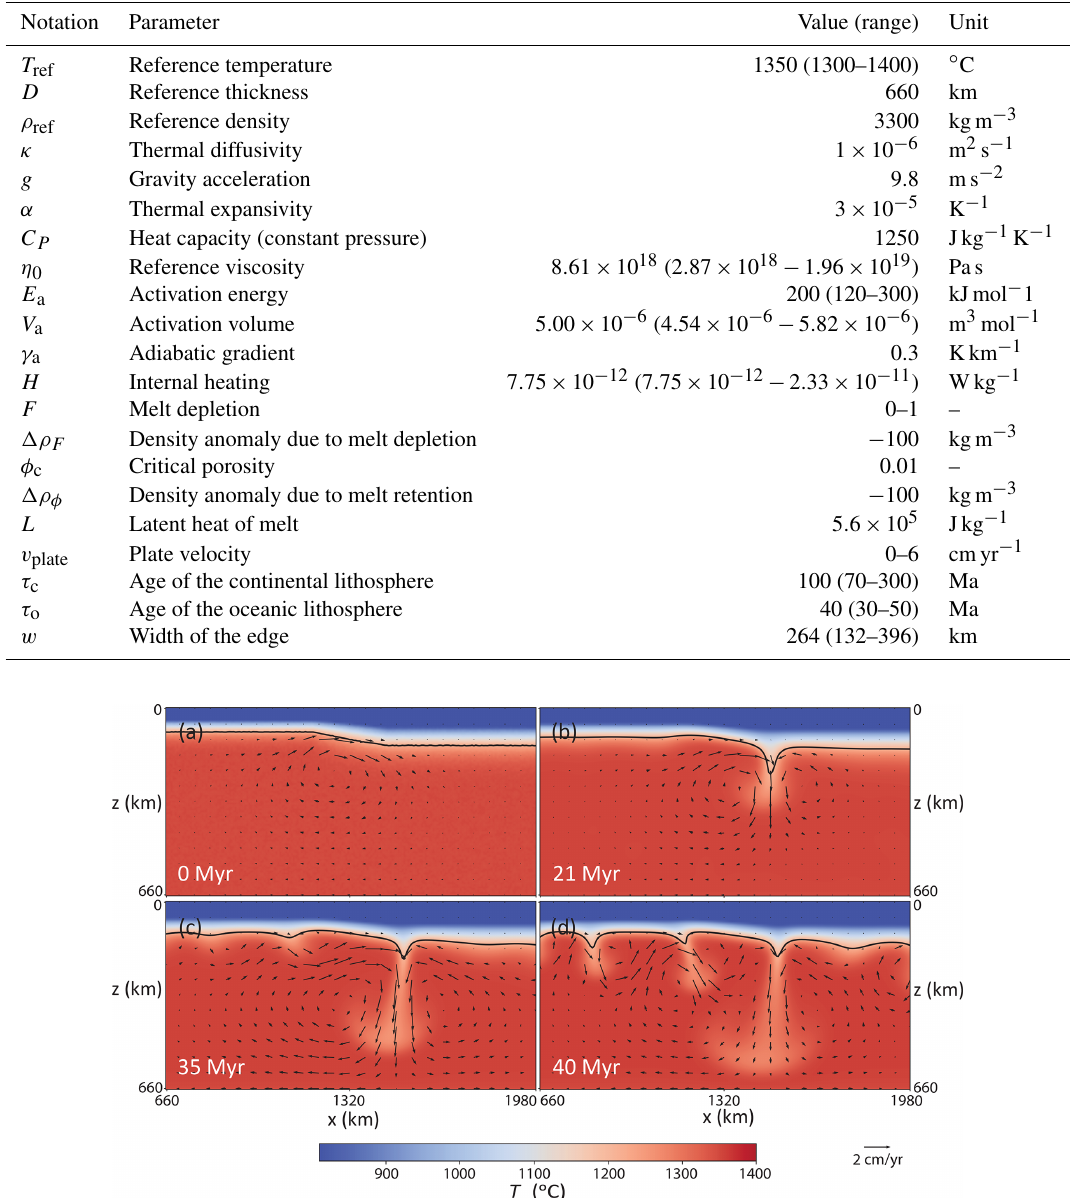
Figure 3. Series of snapshots of potential temperature for the reference case (for parameters, see Table 1). In black, the 1215 ◦ C isotherm (0.9 T ref ) is shown as a proxy for the base of the lithosphere. Arrows reflect the instantaneous velocity field. No melting is predicted by this model at any time